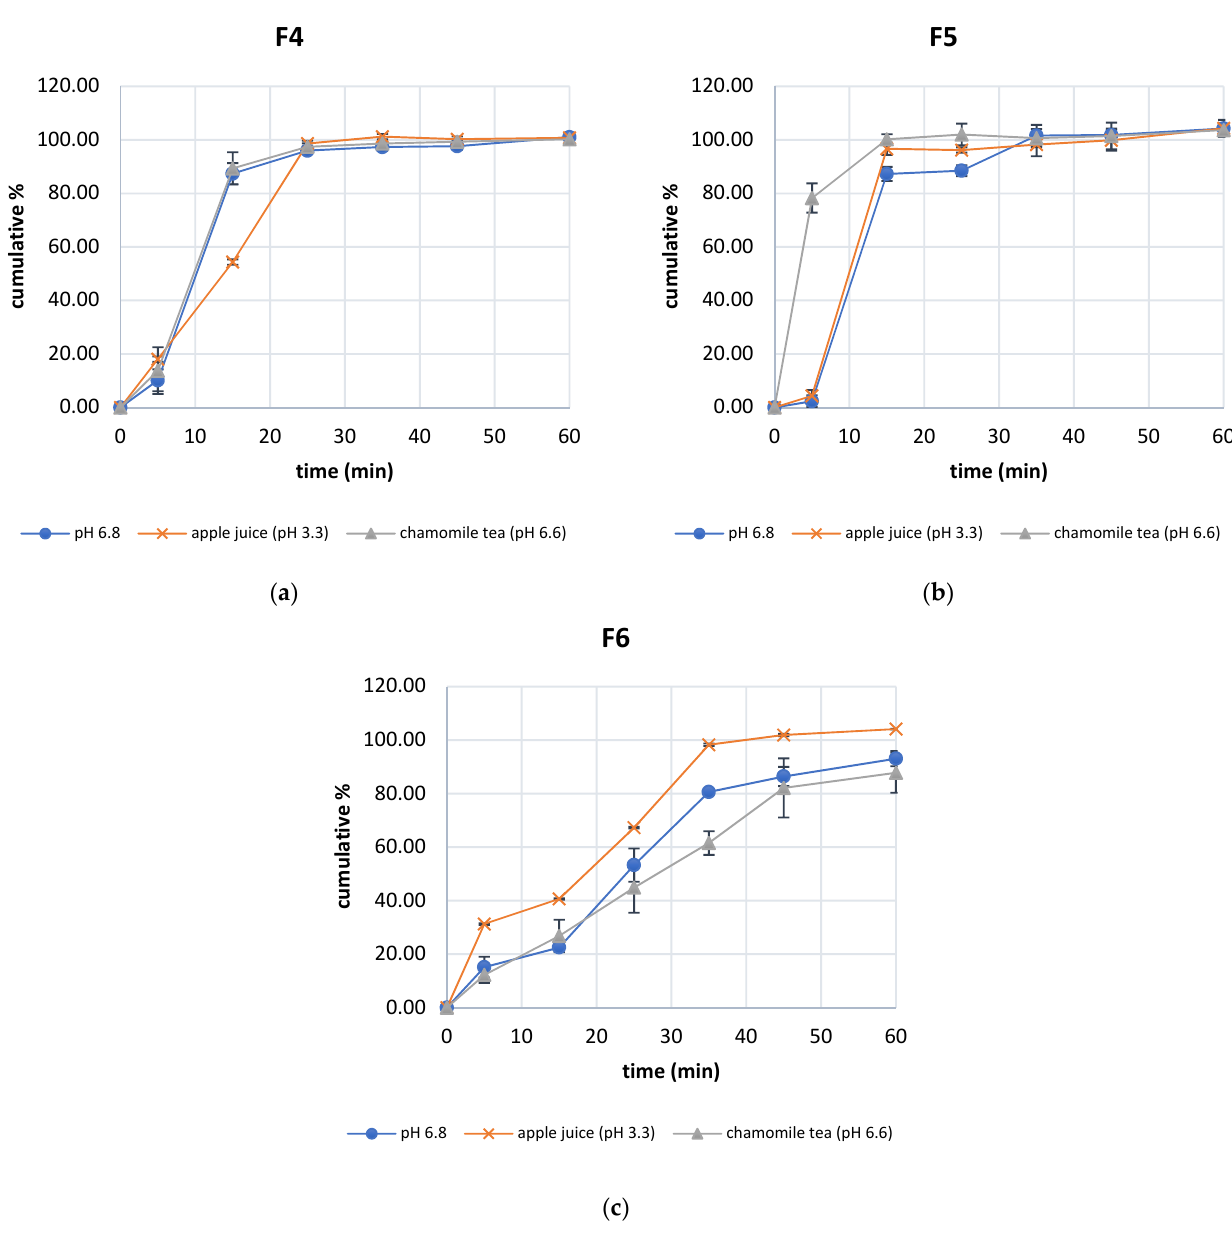
Figure 3. Dissolution profiles for pantoprazole compounded capsules in pH 6.8 dissolution medium and after the addition of 100 mL apple juice and chamomile tea, respectively, for ( a ) F4 (capsule with LAC), ( b ) F5 (capsule with MCC) and ( c ) F6 (capsule with EXCII). Dissolution profile was also influenced by the excipients. The slowest release was measured in formulation F6 (with EXCII), which had peak release after 30 min. Profiles of all excipients were different in all three tested media (Supplementary Table S4).